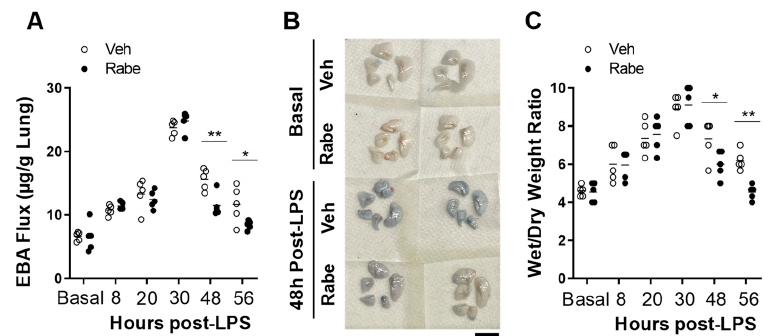
Figure 3. Rabeprazole enhances vascular repair following sepsis-induced inflammatory lung injury. WT mice received PBS vehicle (Basal) or LPS (2.5 mg/kg, i.p.). At 4 and 20 h post-LPS, mice were treated with PBS vehicle or Rabeprazole (18 mg/kg, oral). Lungs were collected at various times post-LPS challenge for EBA flux assay and lung edema assessment. ( A ) EBA flux assay demonstrat- ing that Rabeprazole treatment reduced vascular permeability during the repair phase after LPS challenge but not at baseline or during the injury phase (8–30 h). ( B ) Representative images of lungs from basal mice and LPS-challenged mice at 48 h post-LPS, showing reductions in EBA flux (blue) following treatment with Rabeprazole in LPS-treated mice. Scale bar = 1 cm. ( C ) Lung wet–dry weight ratio demonstrating reductions in lung edema in Rabeprazole- versus vehicle-treated LPS mice during the repair phase but not at baseline or during the injury phase. * p < 0.05 and ** p < 0.01. Two-way ANOVA with Sidak’s multiple comparisons test.